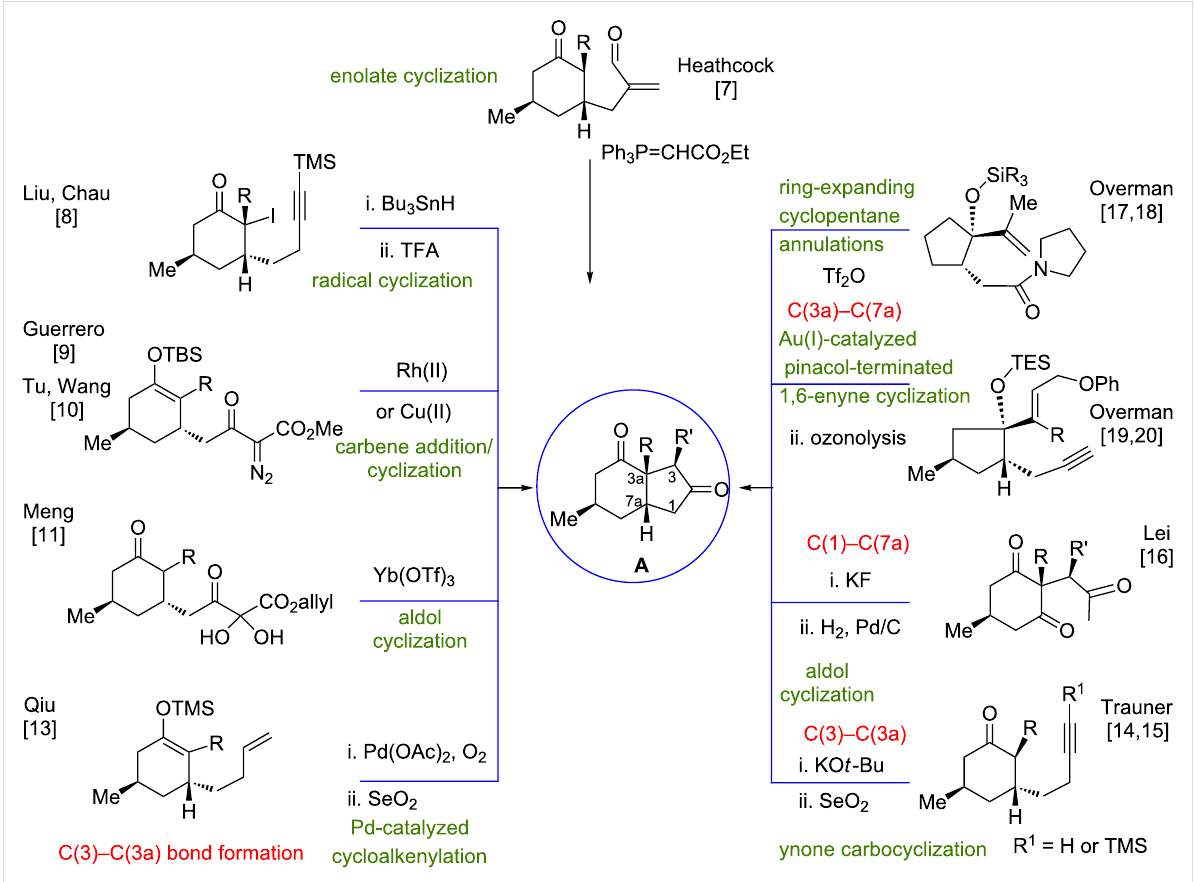
Figure 1: Previous synthetic approaches to 3a-substituted cis -hydrindan-2,4-diones.